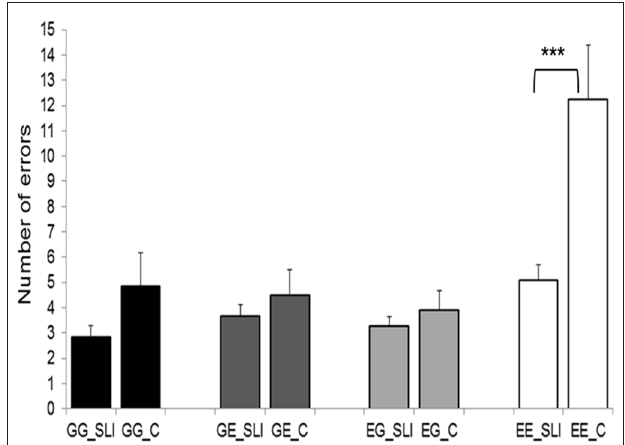
FIGURE 2 | Behavioral results of the semantic decision task. SLI, simultaneous language interpreters; C, multilingual control participants; GG, German-German; GE, German-English; EG, English-German; EE, English-English. Error bars depict standard error. ∗∗∗ p < 0.001.